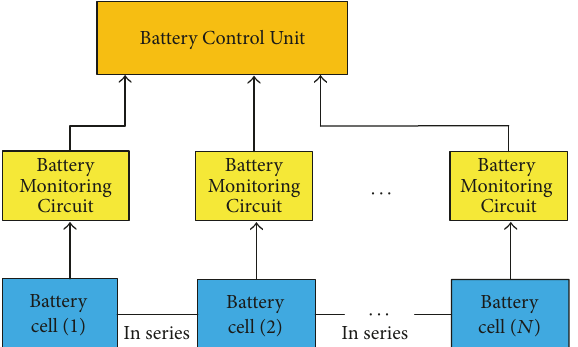
Figure 1: Typical structure of BMS.